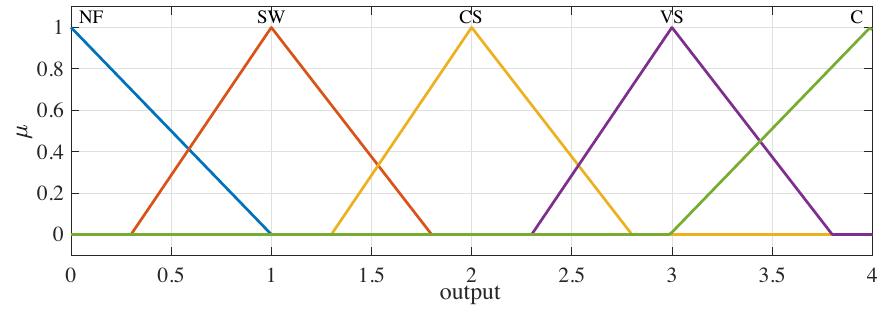
Figure 8. Membership functions of output.